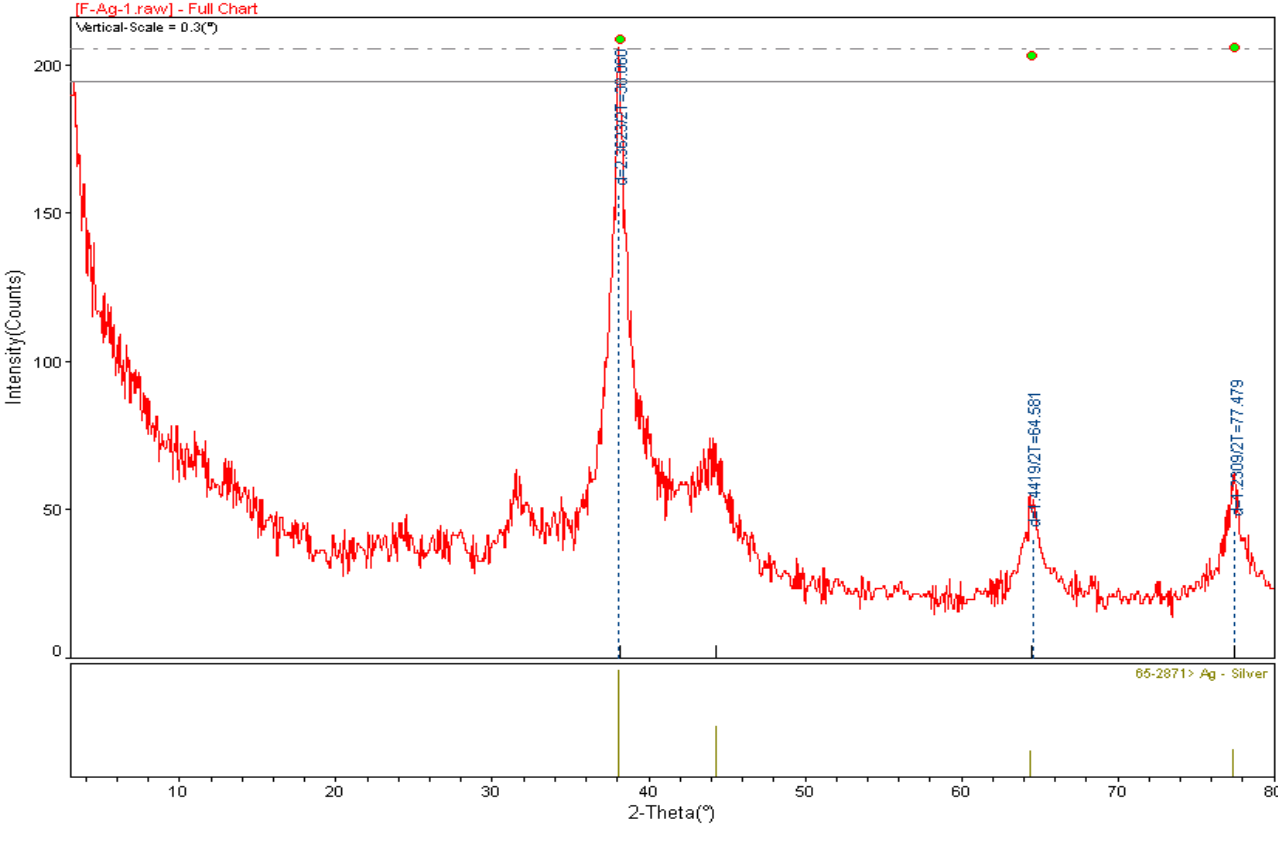
Figure 6. XRD pattern of AC-AgNPs powder crystal structure.